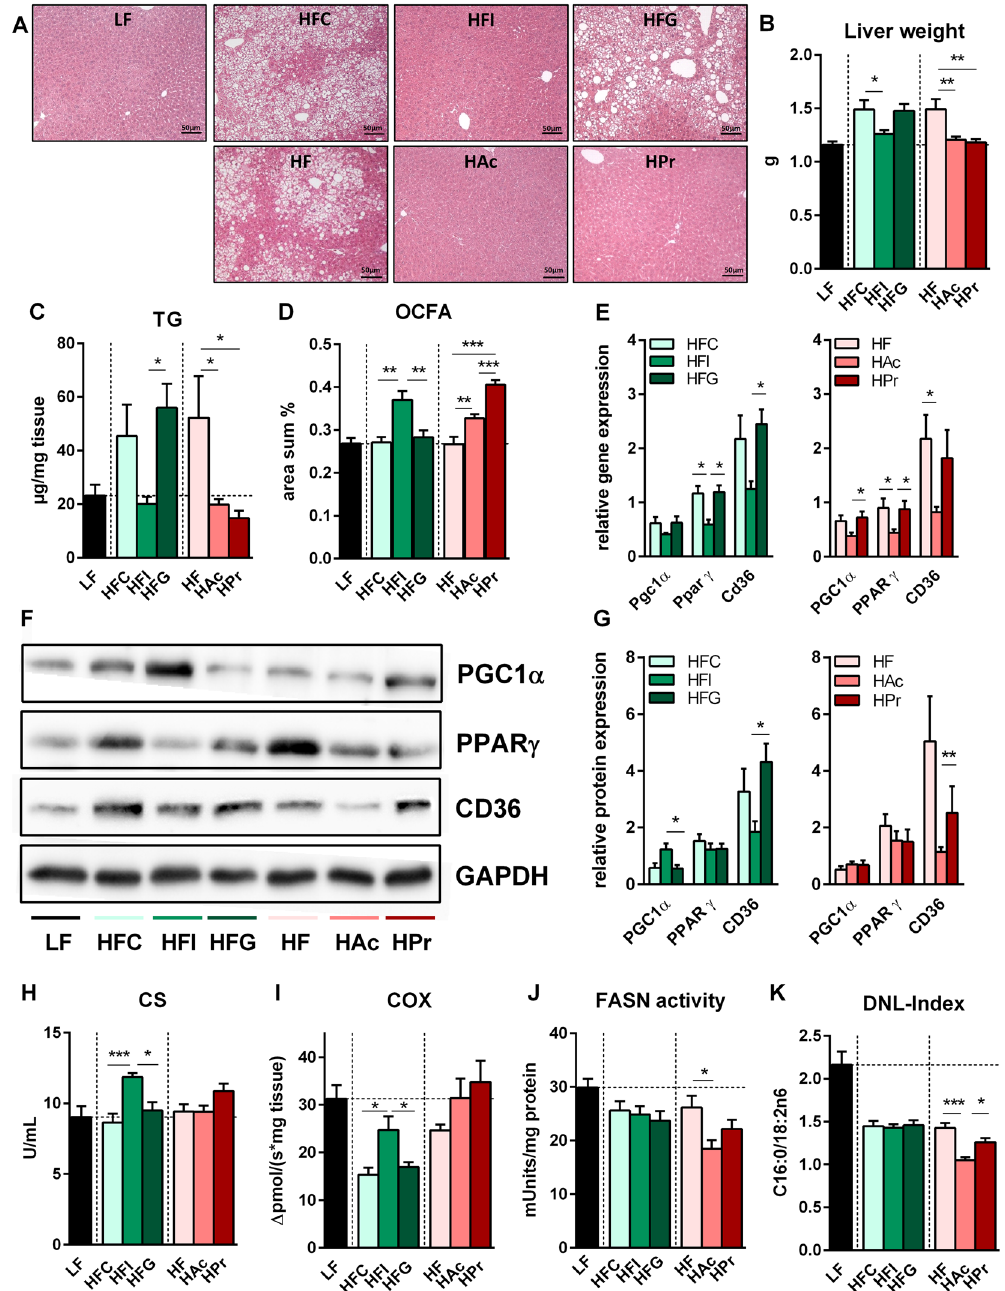
Figure 3. Inulin and SCFA prevent the onset of diet-induced hepatic steatosis by affecting lipid metabolism in different ways. Characterization of liver tissue in male C57BL/6JRj mice that were fed a semi-synthetic low- fat diet (LF) or high-fat diets (HF) supplemented with either 10% dietary fibre (HFC: 10% cellulose; HFI: 3% cellulose + 7% inulin; HFG: 3% cellulose + 7% guar gum; depicted in green hues) or 5% SCFA (depicted in red hues) with different Ac:Pr ratios, a high acetate (HAc; 10:1 Ac:Pr) or high propionate diet (HPr; 1:2.5 Ac:Pr) for 30 weeks. ( A ) Representative H&E staining of hepatocytes after intervention. ( B ) Liver tissue weight (n = 19– 21) and corresponding ( C ) hepatic triglyceride (TG) concentration, n = 9–11. ( D ) Formation of odd-chain fatty acids (OCFA) in liver phospholipid fraction, n = 8. ( E ) Hepatic gene expression, ( F ) respective western blots with corresponding load control (GAPDH) and ( G ) analysis of protein expression (normalized to LF-diet as set to a value of 1), n = 4–8. Analysis of ( H ) citrate synthase (CS) and ( I ) cytochrome c oxidase (COX) activity in liver, n = 5–8. ( J ) Hepatic fatty acid synthase (FASN) activity and ( K ) calculated de novo lipogenesis (DNL)- Index by measurement of long-chain fatty acid amount in liver phospholipids, n = 8. Data are mean + SEM. * P < 0.05; ** P < 0.01; *** P <